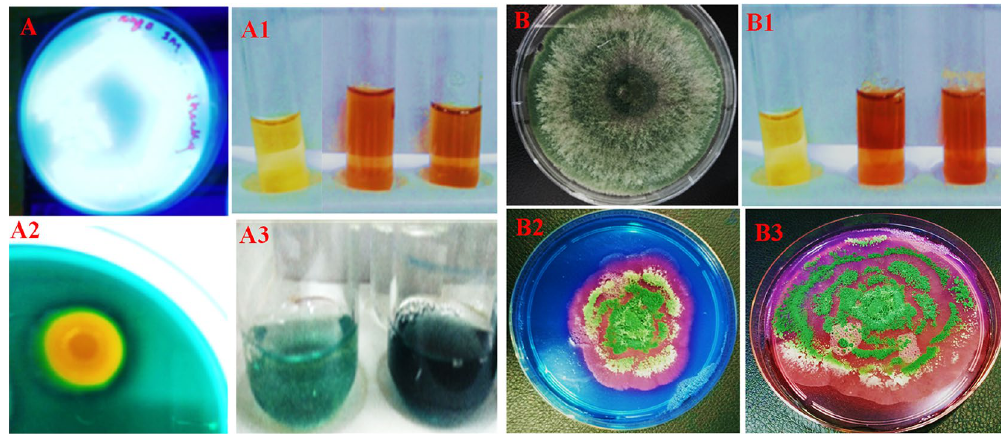
Figure 1. Pseudomonas PGPR-7 strain under UV light showing fluorescent ( A ). Ferric chloride (FeCl 3 ) test indicating the production of siderophore ( A1 ). Zone of halo formed by PGPR-7 strain on CAS gar plate ( A2 ), and quantification of phenolate siderophore ( A3 ). Trichoderma culture on PDA plate ( B ), FeCl 3 test for siderophore production ( B1 ). Panels B2 and B3 depicting the siderophore production ability of Trichoderma sp.